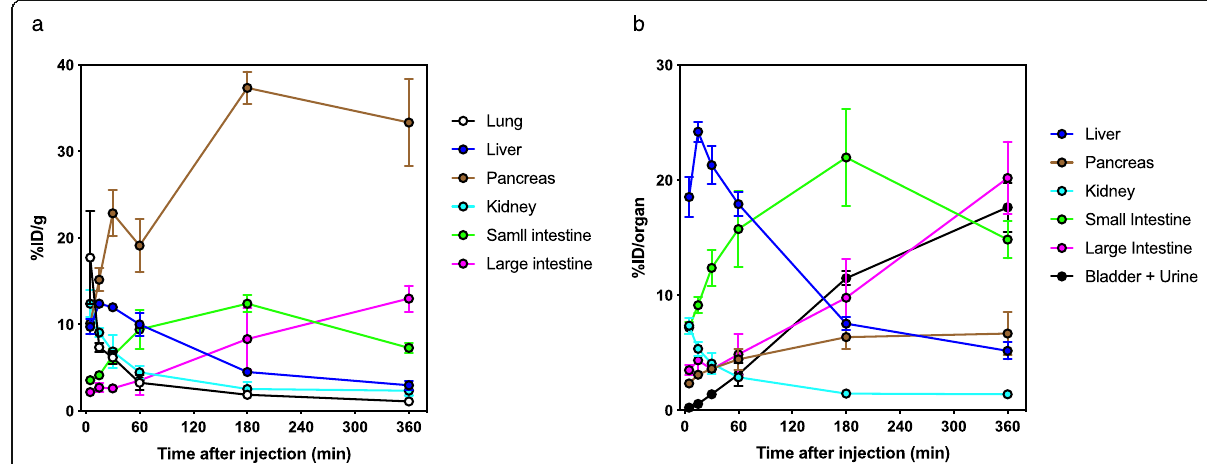
Fig. 4 Regional decay-corrected time activity curves showing high radioactivity concentration ( a ) and accumulation ( b ) after intravenous injection of [ 18 F]MC225 into mice. Data are presented as the mean ± S.D. ( n =